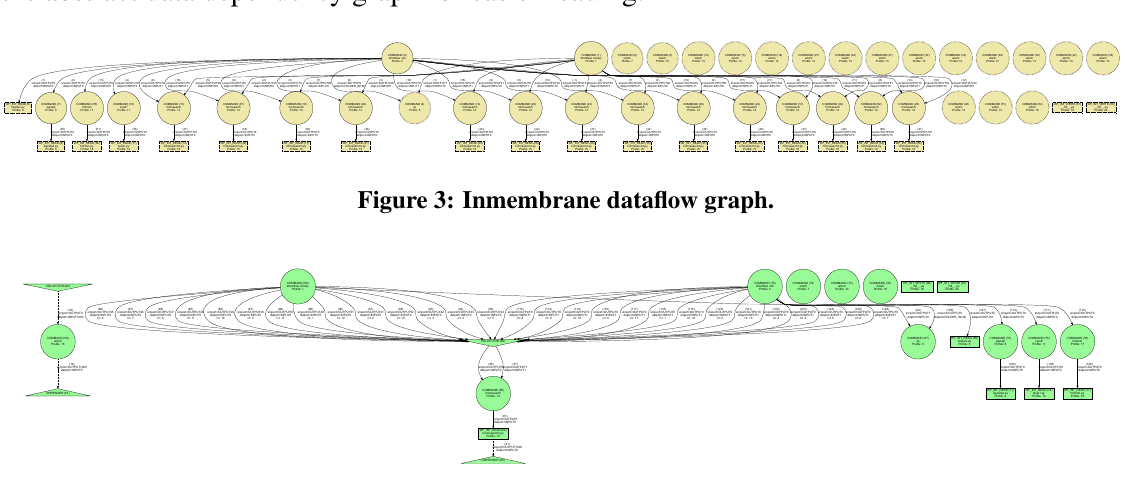
Figure 4: Abstract data dependency graph for